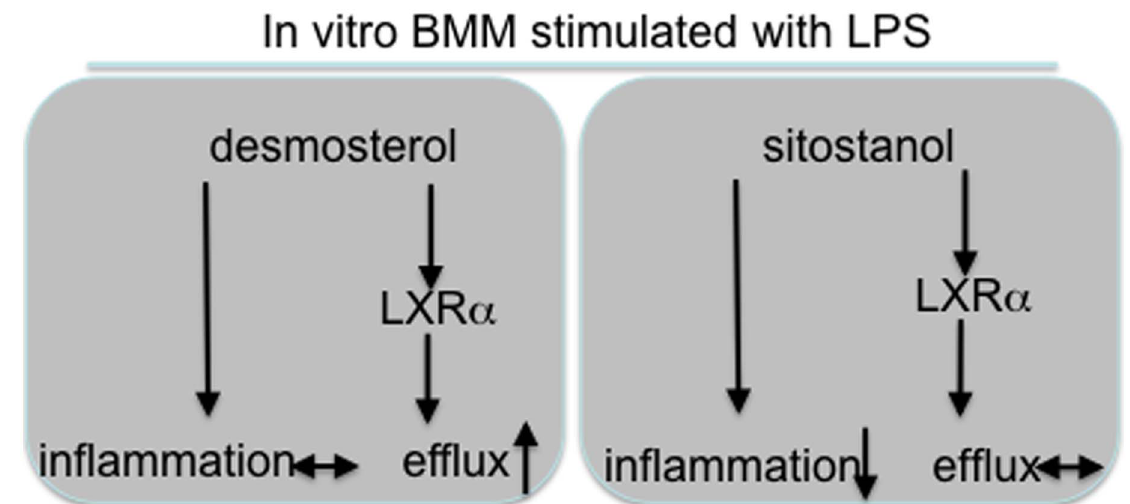
Figure 9. Schematic representation of direct effects of sitostanol vs desmosterol.